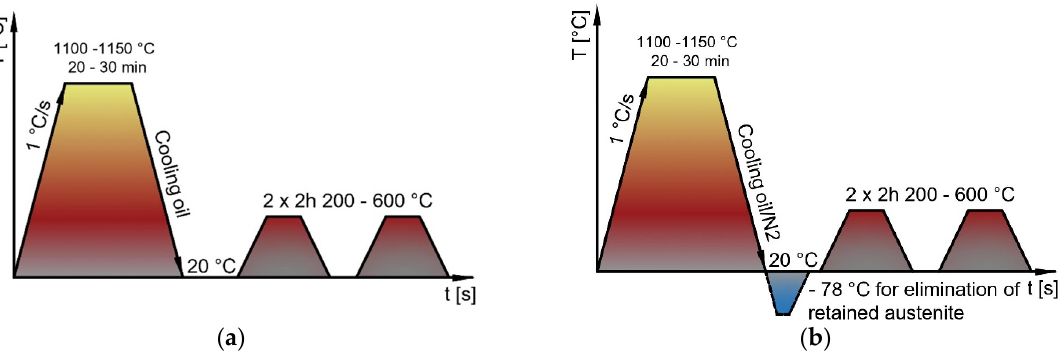
Figure 2. Schematic diagram of thermal processes of M390 and M398 steels: ( a ) without deep freezing; ( b ) with deep freezing.